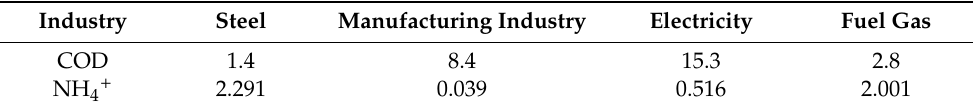
Table 5. Unit virtual abatement costs of water pollution (CNY /